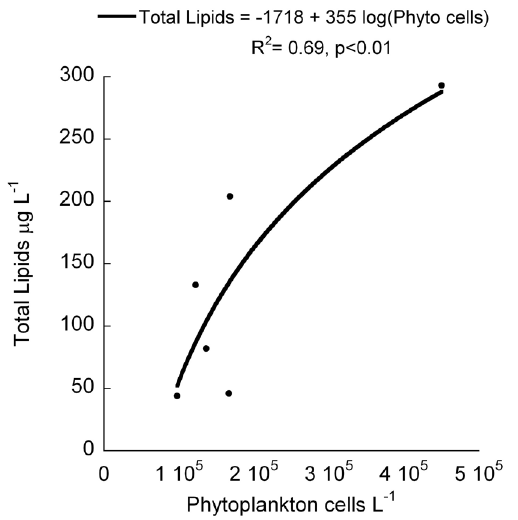
Fig . 5. – Total lipid (µg L -1 ) and total cell concentration (cells L -1 ) relationship during the 48-hour cycle at Chipana Bay. Equation and significance are